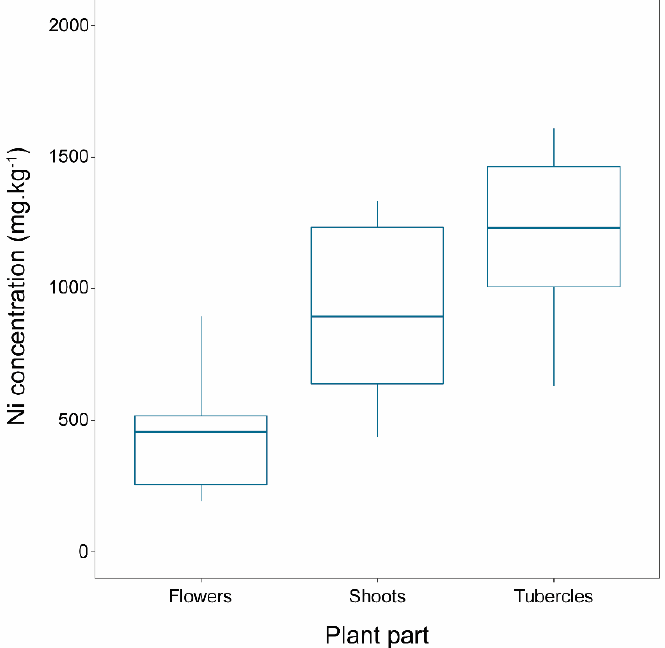
Figure 1. Ni concentration (mg.kg − 1 ) in different parts (flower, shoot, and tubercle) of Phelipanche nowackiana individuals collected from Olympos, Lesbos, Greece. The central horizontal line in the box plots represents the median of the samples; the box plot edges represent the first and third quartile. The interquartile range (IQR) within the boxes present the central 50% of the values. The whiskers show the range of observed values and the locations of the minimum and the maximum values. No significant interaction between site and plant part on Ni concentration was ob- served for P. nana individuals (Figure 2). The main effect of site on Ni concentration was not significant at a = 0.05 ( p = 0.064), but a statistically significant variation was observed in the Ni concentration of the different parts (F 2,32 = 10,537, p < 0.001). The average Ni concentration of the flowers differed significantly from those of the shoots ( p = 0.007)